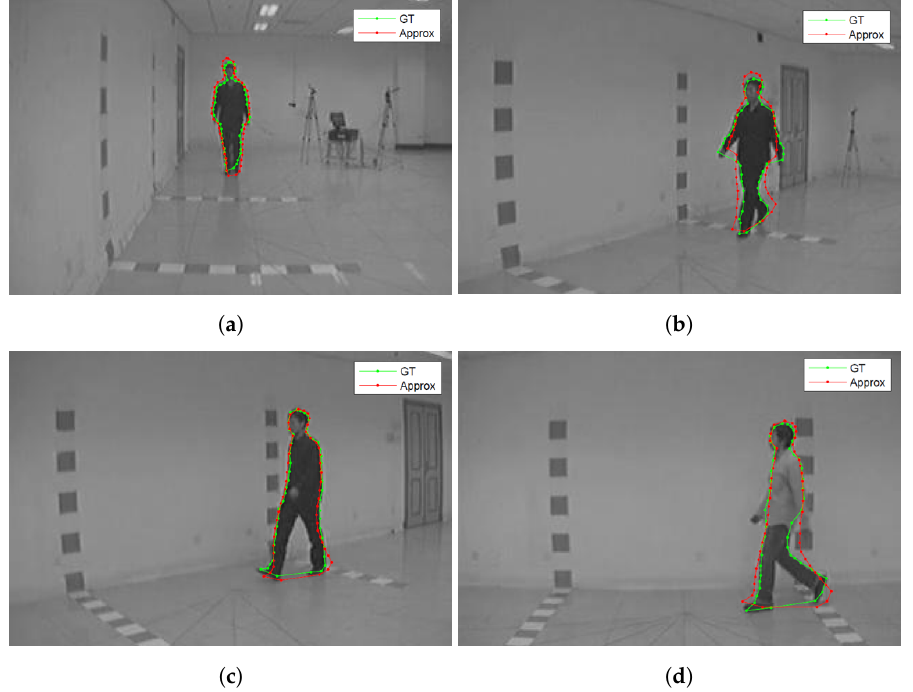
Figure 11. Detection of a pedestrian walking at different orientations with respect to the camera in the CASIA Gait dataset. ( a ) Pedestrian walking at 0 degrees. ( b ) Pedestrian walking at 36 degrees. ( c ) Pedestrian walking at 54 degrees. ( d ) Pedestrian walking at 90